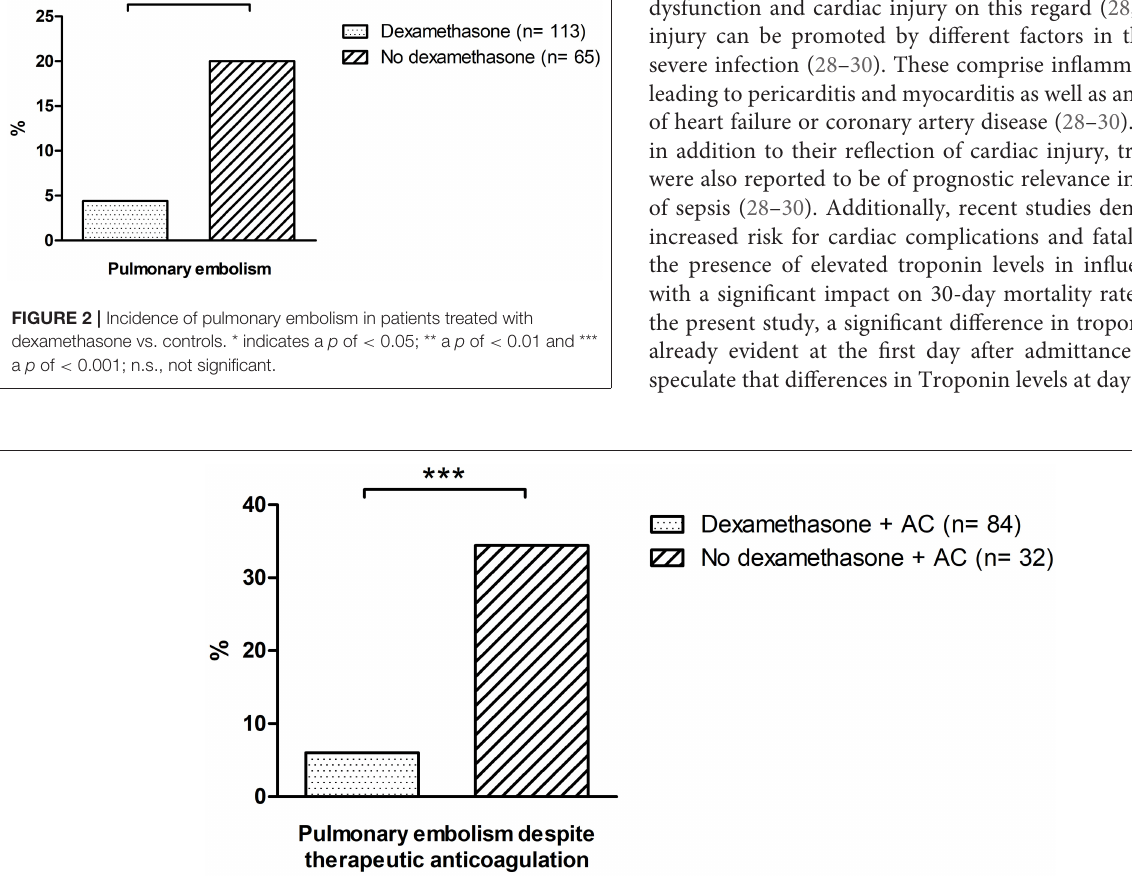
Frontiers in Medicine |